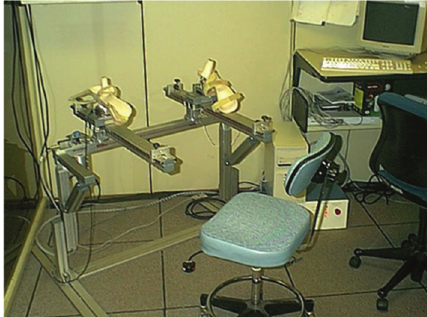
Figure 10: ARCMIME. Reprinted with permission